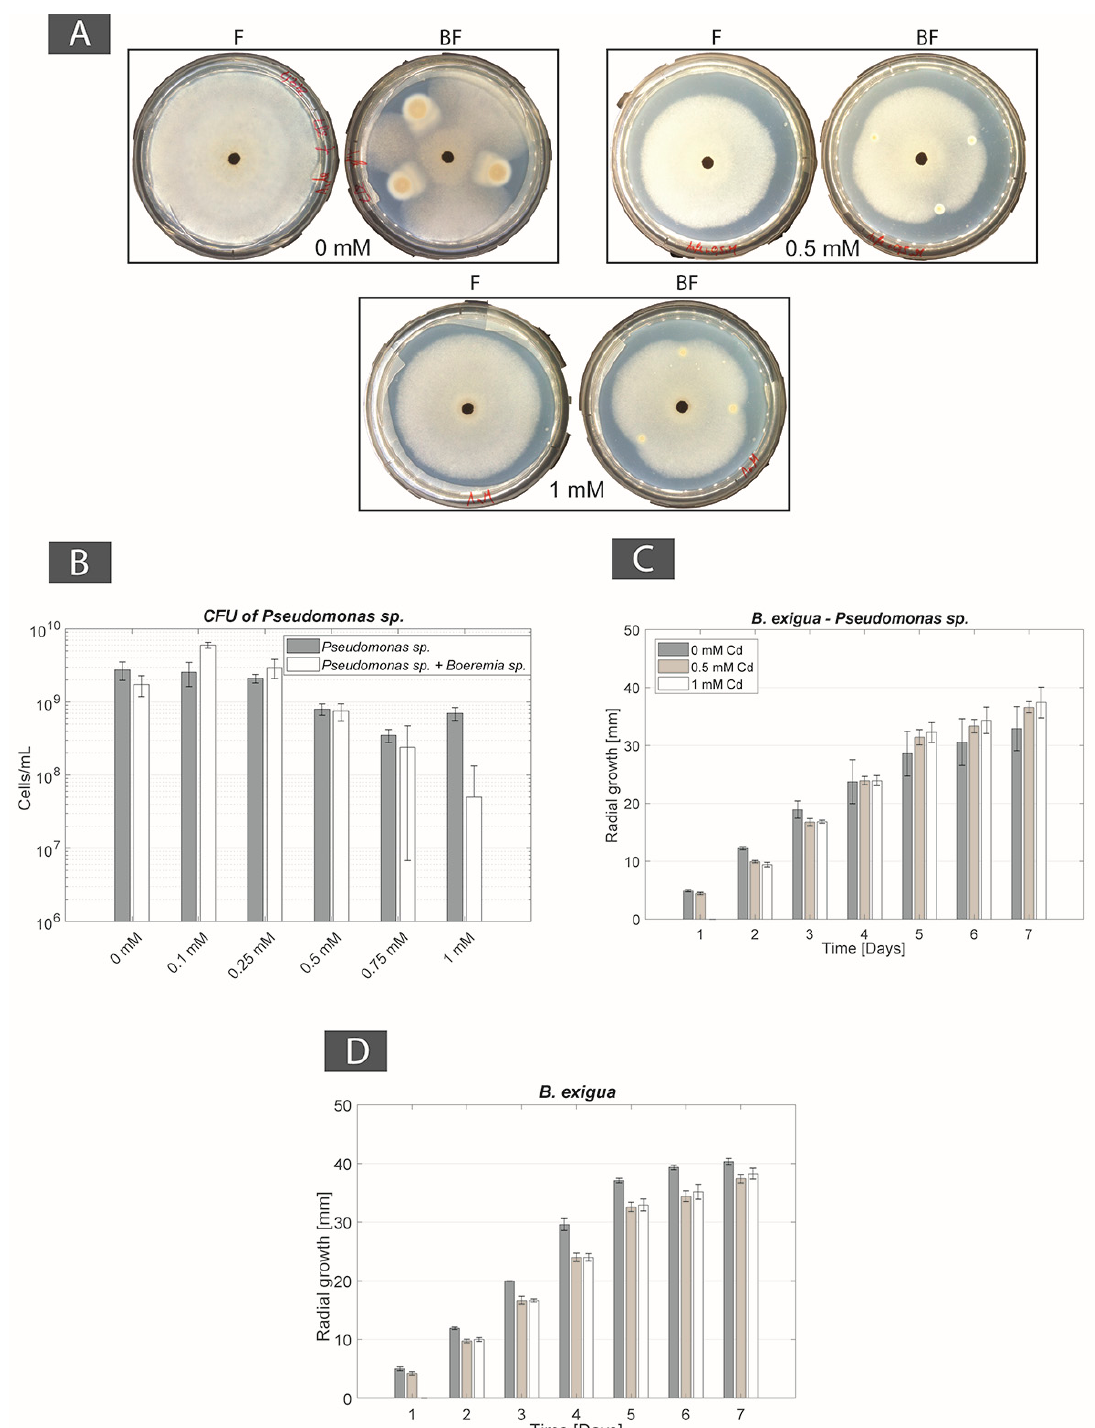
Figure 2. ( A ) Photographs of mono-cultures of Boeremia exigua (F panels) and co-cultures of B. exigua + Pseudomonas sp. (BF panels) in Angle medium (0 mM Cd) and Cd-containing Angle medium (0.5 and 1 mM Cd); ( B ) Pseudomonas sp. CFU counts in mono-culture and co-culture with B. exigua in Angle medium (0 mM Cd) and Cd-containing Angle medium (0.5 and 1 mM Cd); ( C ) Radial mycelial growth of B. exigua in co-culture with Pseudomonas sp. in Angle medium (0 mM Cd) and Cd-containing Angle medium (0.5 and 1 mM Cd); ( D ) Radial mycelial growth of B. exigua in mono-culture in Angle medium (0 mM Cd) and Cd-containing Angle medium (0.5 and 1 mM Cd).